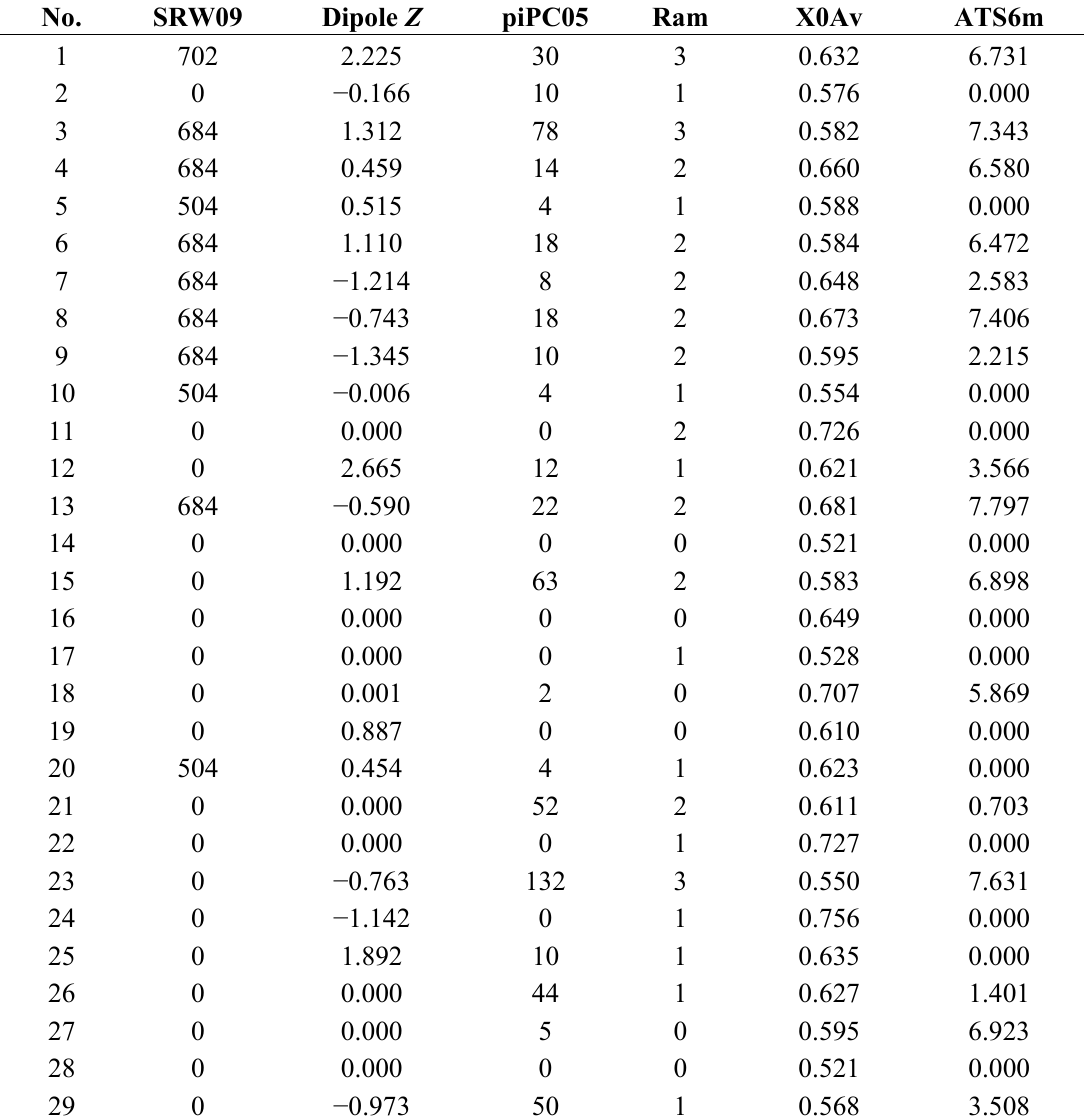
Table 4. The descriptor values for organic